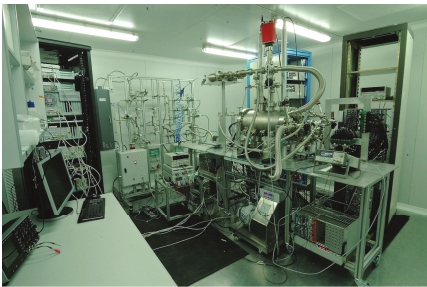
Figure 21: The NEXT-DEMO detector and ancillary systems (gas system, front-end electronics, and DAQ) in their location in the operation room at IFIC.